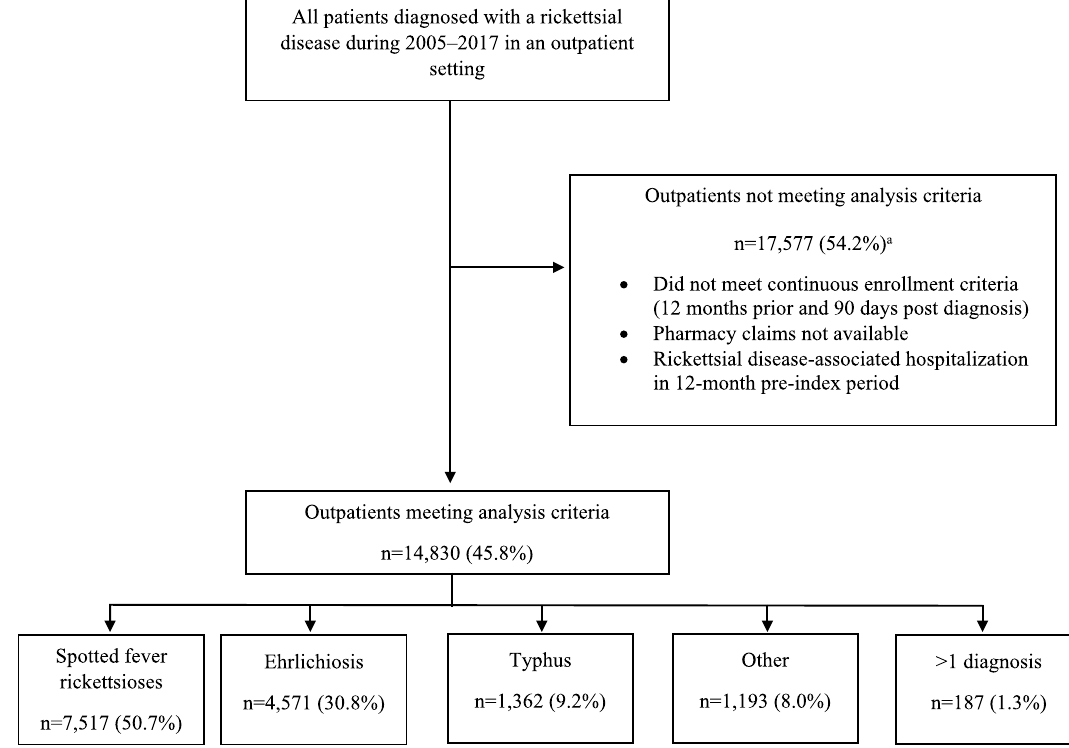
Figure 1. Selection criteria for outpatients diagnosed with rickettsial diseases from a large, commercially insured population—United States, 2005–2017. a Exclusion criteria are not mutually exclusive; outpatients could be excluded for failing to meet more than one criteria